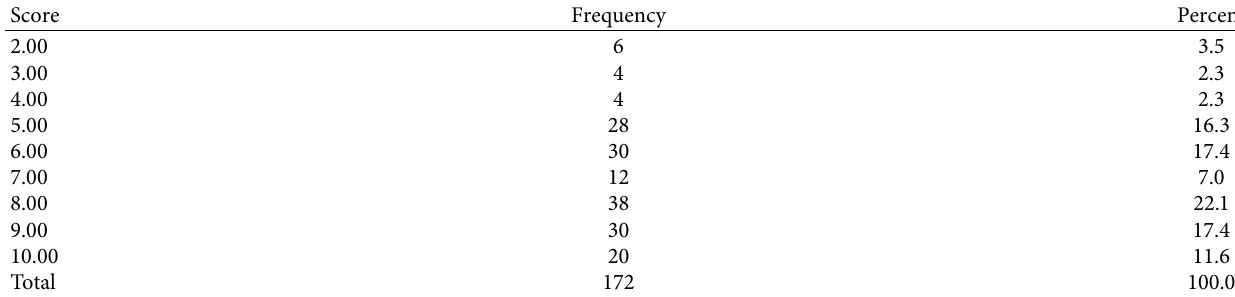
Table 4: Performance of companies in stakeholder